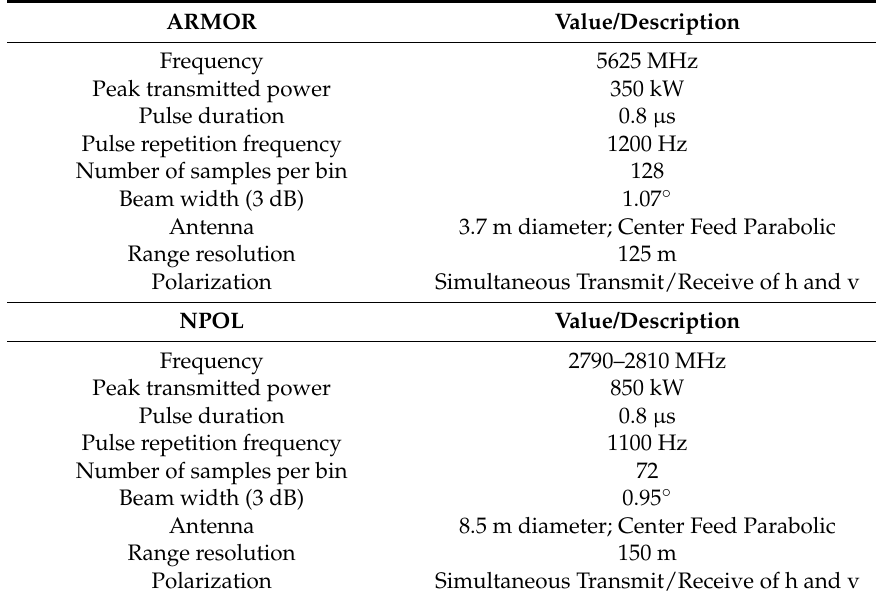
Table 1. Characteristics of the Advanced Radar for Meteorological and Operational Research (ARMOR) and NASA’s dual-polarimetric S-band (NPOL) radars used in this